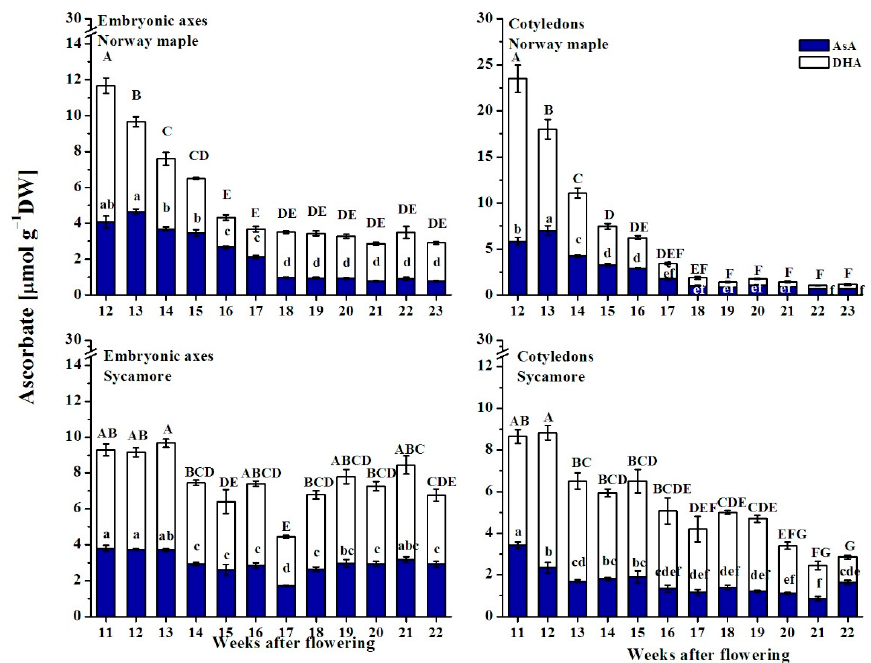
Figure 10. Changes in the levels of the reduced (AsA) and oxidized (DHA) forms of ascorbate reported in the embryonic axes and cotyledons of the developing seeds of Norway maple and sycamore collected during the 11th–23rd weeks after flowering. Data are the means of three independent replicates ± the standard error. Statistically significant differences are indicated with different letters (one-way ANOVA, followed by Tukey’s test at p < 0.05). The capital letters refer to DHA. There was a clear difference in the AsA/DHA ratio between Norway maple and sycamore embryonic axes (Figure 11A). A relatively unchanged AsA/DHA ratio of 0.75 was reported in sycamore, whereas in Norway maple, the AsA/DHA ratio increased until it reached a value of approximately two at the 16–17th WAF, after which it substantially decreased and remained unchanged until the end of maturation. The cotyledons of Norway maple and sycamore differed markedly between the 18/19th and 21st/22nd WAF. At this time, the AsA/DHA ratio was remarkably high in Norway maple cotyledons and peaked at three, whereas in sycamore, the ratio did not exceed 0.5.